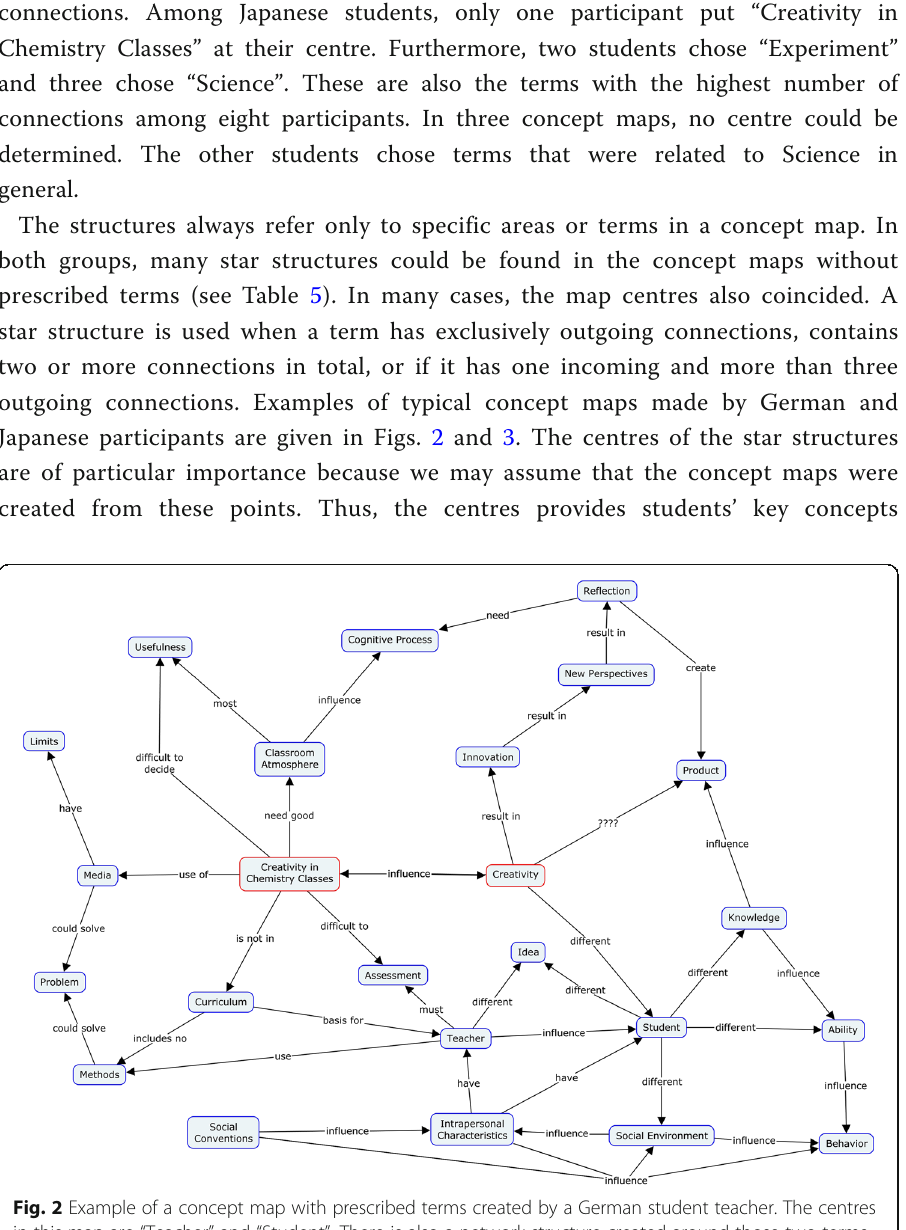
Table 5 Number of different structures in the concept maps of German students (G, N = 16) and Japanese students (J, N = 14) Structure Star (G/ Number of structures in the concept maps without prescribed terms